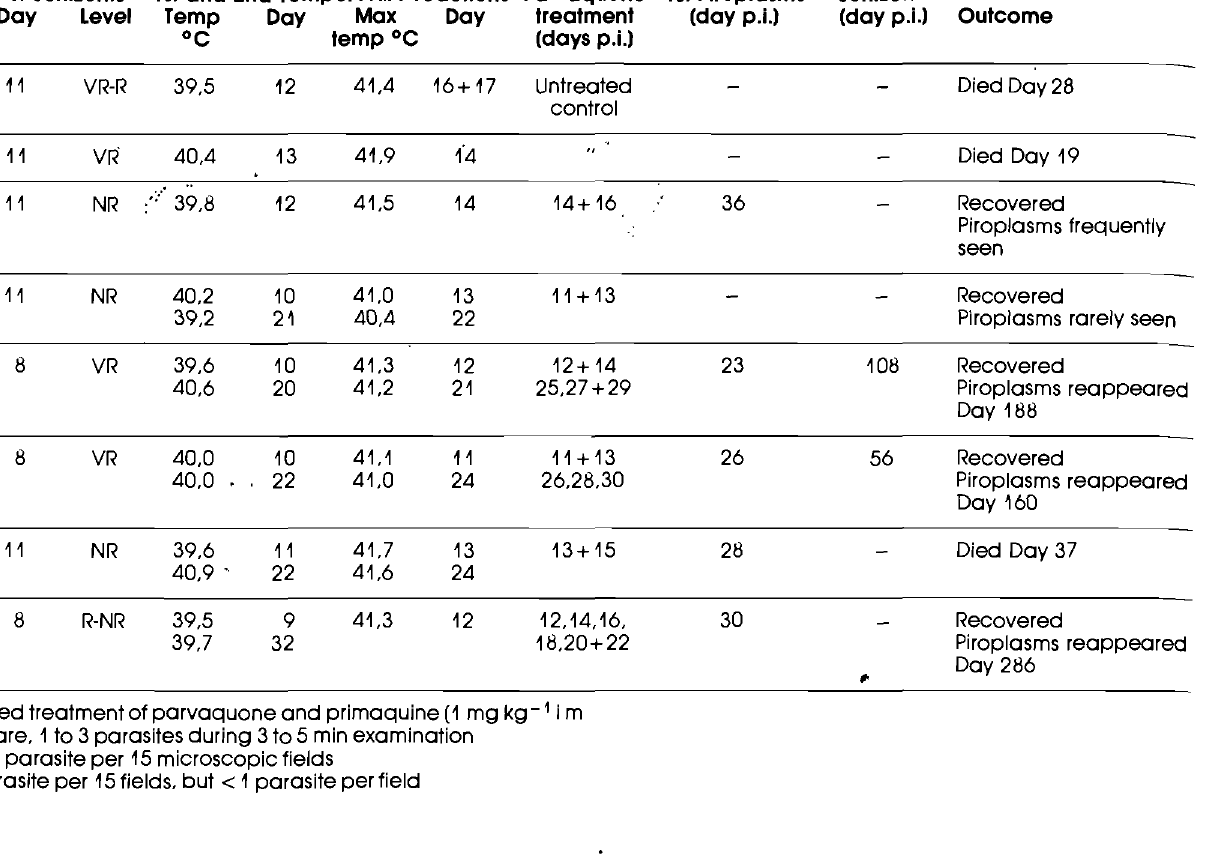
Table 3: Chemotherapy of tick-transmitted Theileria parva lawrencei infections in splenectomised cattle using parvaquone at Q dosage rate of 10 mg kg- 1 i m 1st Schizonts 1st and 2nd Temperature reactions Parvaquone 1 st Piroplasms